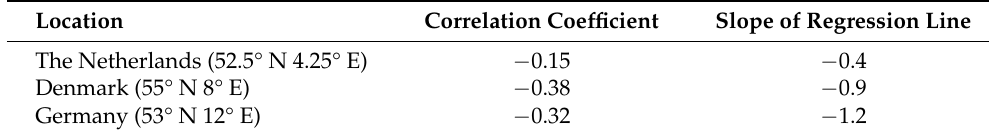
Table 1. Statistical model results: electricity price dependency on wind speeds for three different European locations.